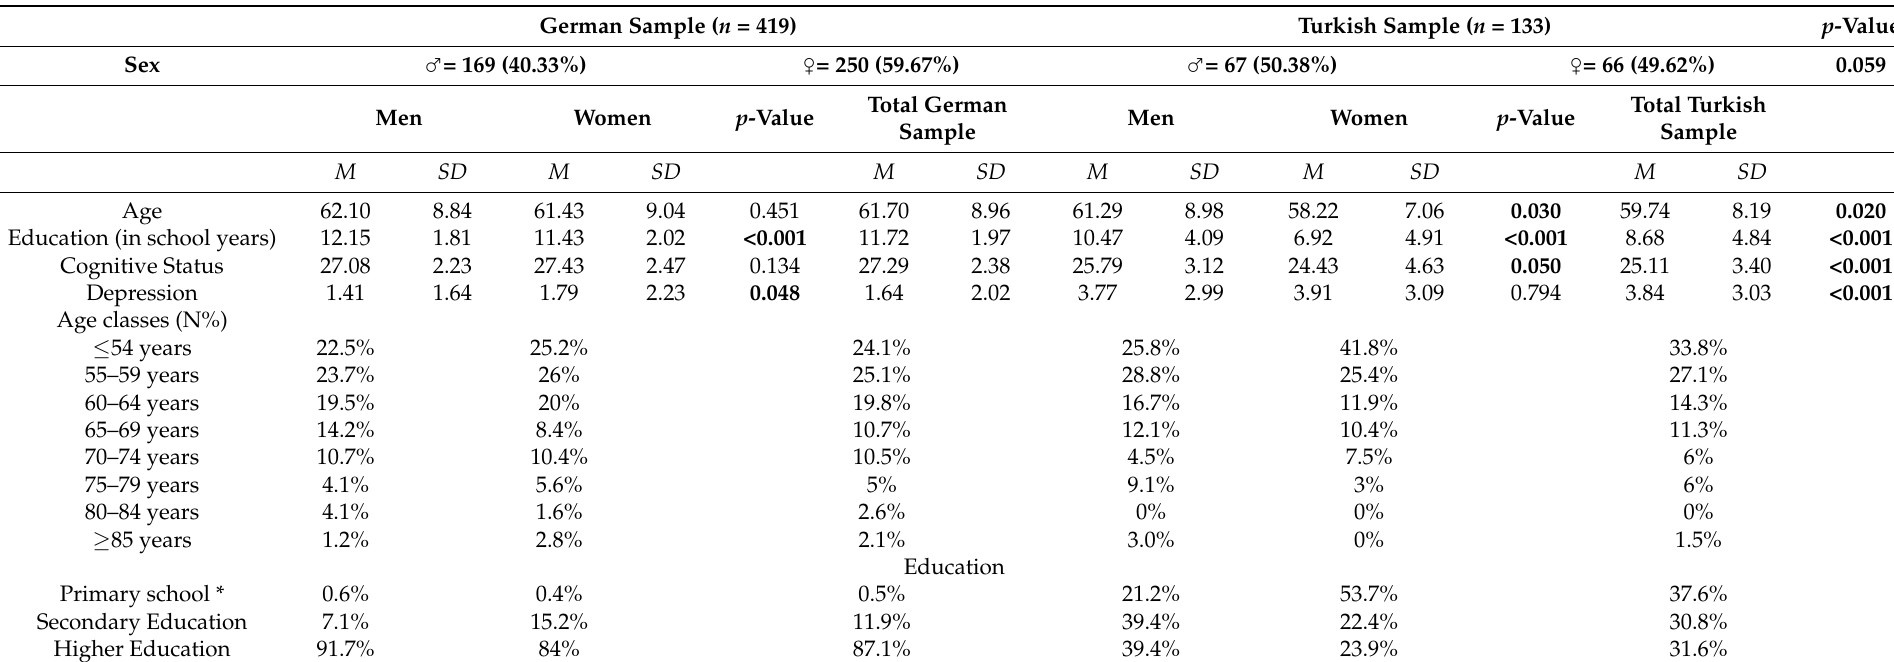
Table 1. Characteristics of the German and Turkish